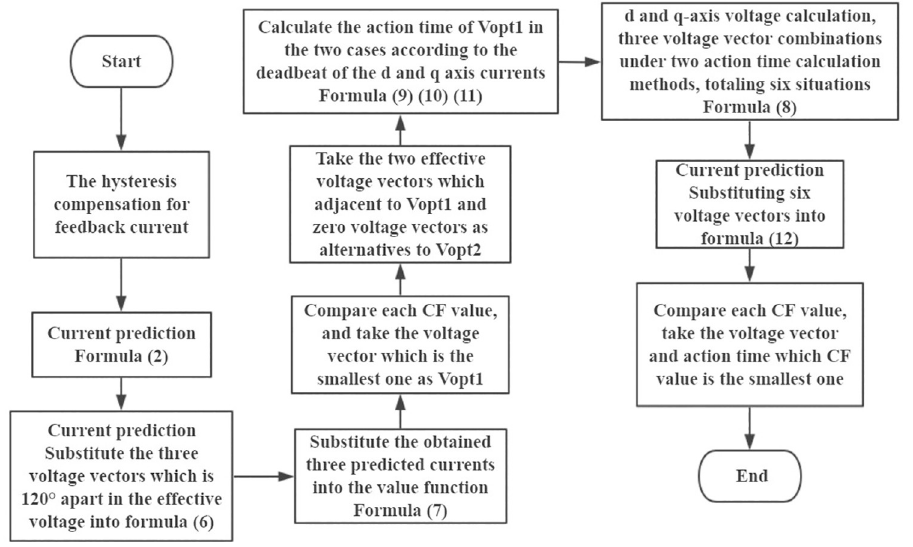
Fig 6. Flowchart of the dual-vector MPCC